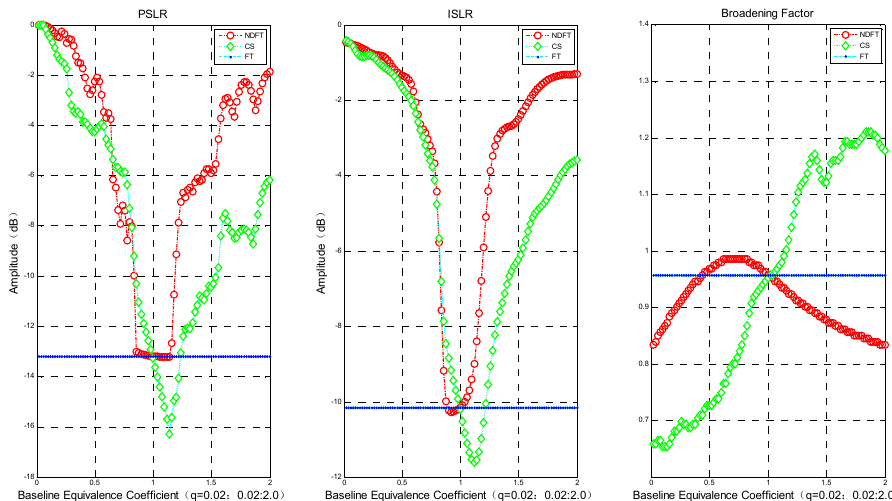
Figure 4. Imaging performance in the height direction: PSLR, ISLR, broadening coe ffi cient. The blue